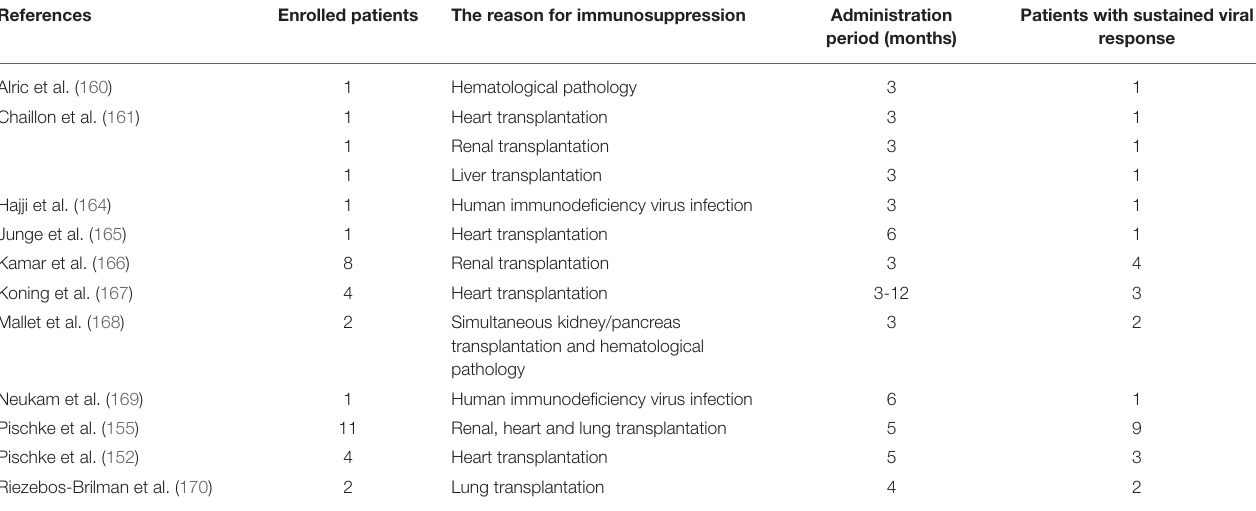
TABLE 7 | Efficacy of ribavirin monotherapy in immunosuppressed